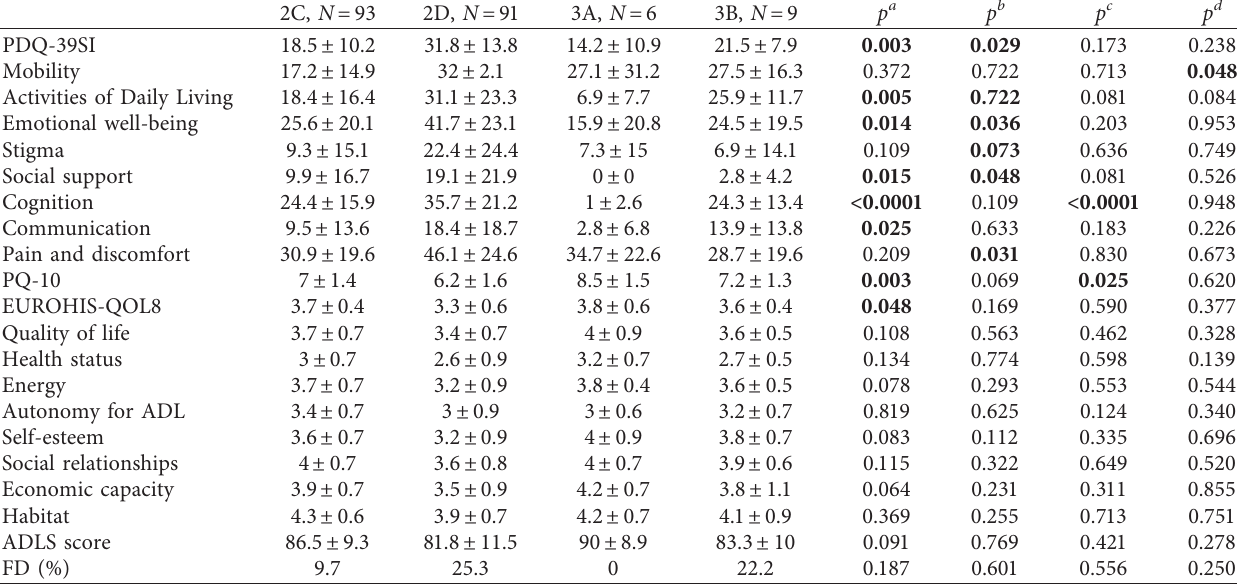
Table 4: Quality of life (PDQ-39SI and EUROHIS-QOL8) and disability (ADLS score) in patients with stages 2C, 2D, 3A, or 3B of the HY- NMSB scale.